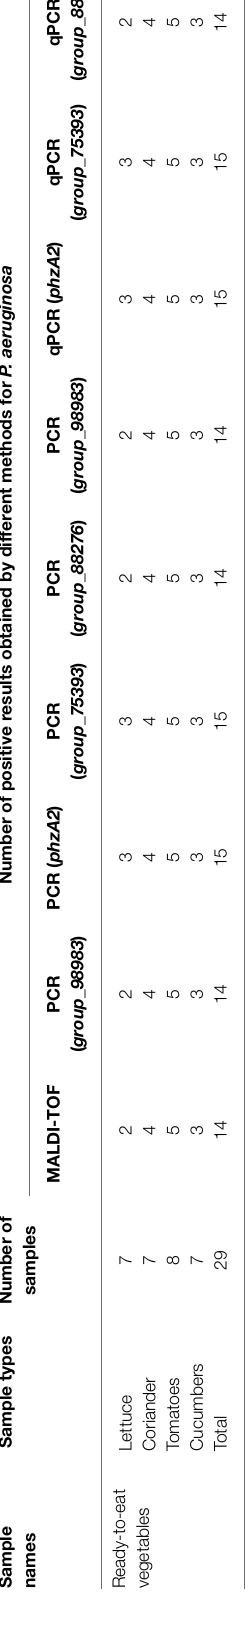
TABLE 4 | Presence profile of novel and reported P. aeruginosa species-specific gene targets for target and nontarget